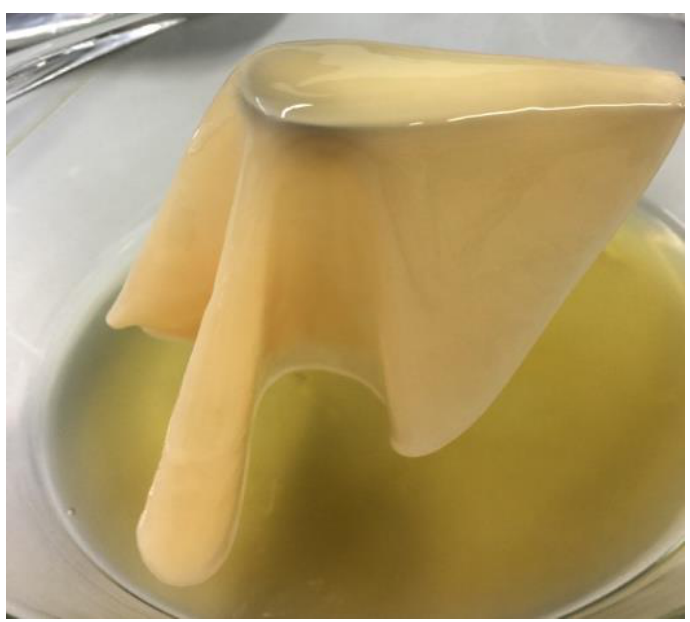
Figure 4. Production of cellulose with strain AV436 on RAE medium.